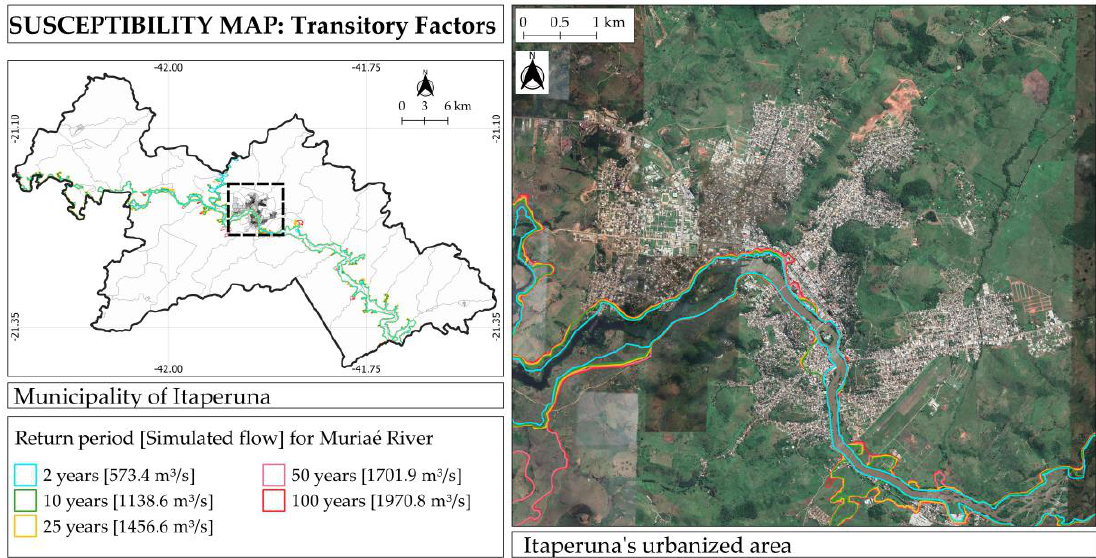
Figure 6. Flood susceptibility map (based on transitory factors) of the municipality of Itaperuna categorized by different return periods: 2, 10, 25, 50, and 100 years.